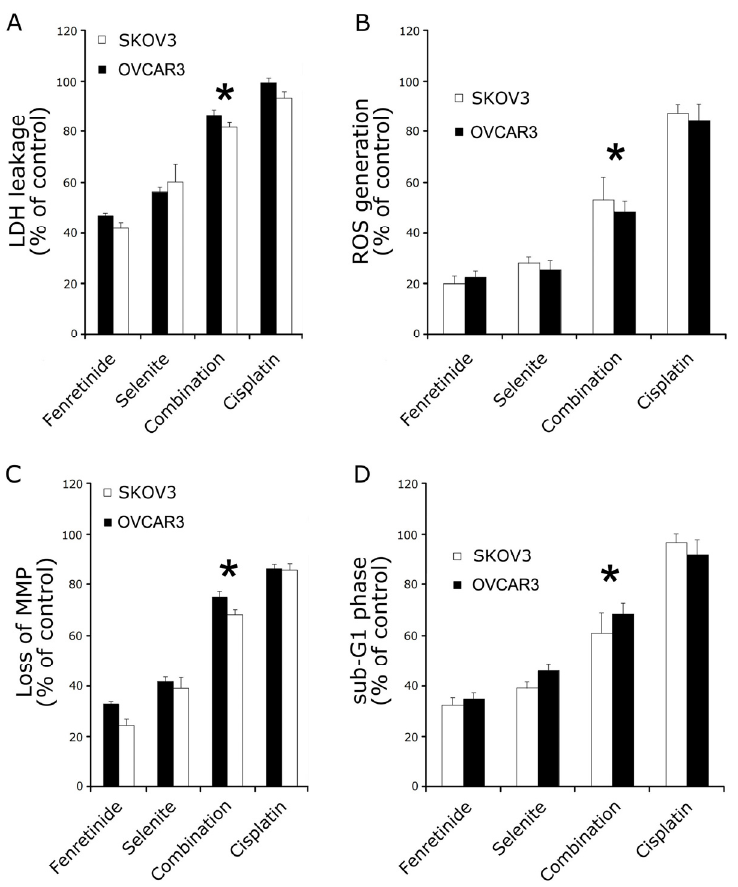
Figure 2. Fenretinide and selenite cytotoxicity on SKOV3 and OVCAR3 cells. After drug alone (10 µmol/L fenretinide, 10 µmol/L selenite) or drug combination (10 µmol/L fenretinide plus 10 µmol/L selenite) exposure for 48 h, lactate dehydrogenase (LDH) leakage assay ( A ); intracellular reactive oxygen species (ROS) generation assay ( B ); mitochondrial membrane potential (MMP) loss assay ( C ) and the sub-G1 phase cells analysis ( D ) were performed. (means ± s.d., * p <